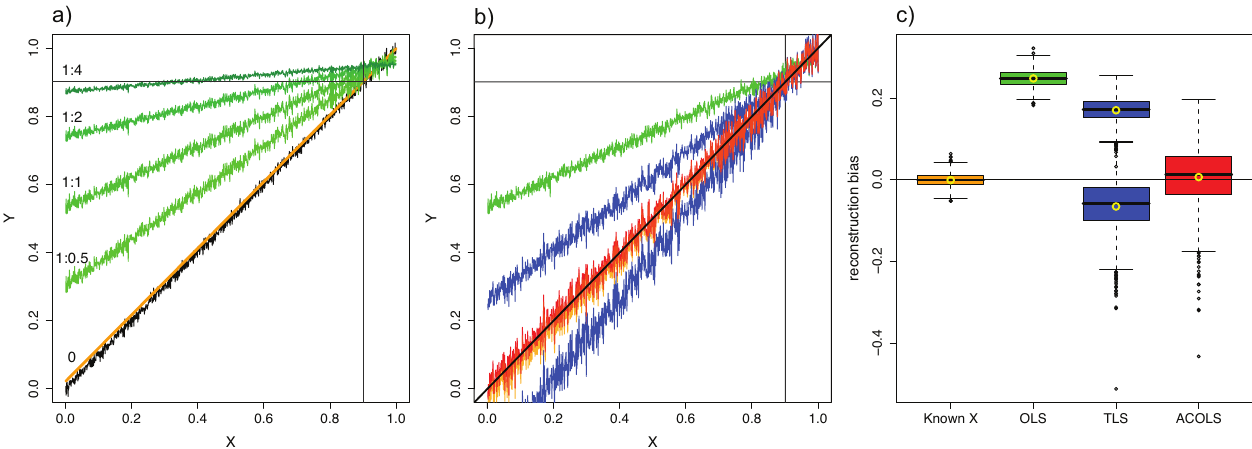
Fig. 1. Influence of increasing noise in predictors of simple linear models where the calibration is restricted to the interval 0.9–1.0 in the response variable Y and prediction extends to 0. (a) Traditional OLS regression exhibits rapid increase in attenuation of the true (orange) linear relationship as the signal-to-noise ratio (S:N) becomes dominated by the noise; (b) The OLS (green) regression result S:N=1:1 from (a) is corrected using two possible TLS-answers (blue) based on the assumptions that either all noise is in X ( η =0) or where the noise in X and Y are thought to be equal ( η =1). Depending on estimation of parameters η , solutions for TLS will most likely be somewhere in between. ACOLS (red) solutions are close to the true regression coefficients (orange), yet the variance is somewhat increased. (c) Box-plots representing the range of solutions over 1000 replicates for applications shown in